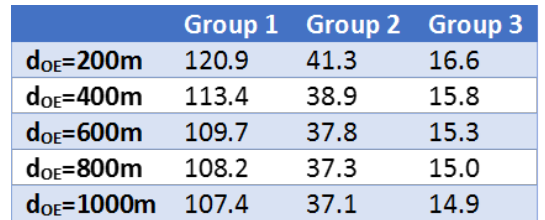
Table 2. Updated average density of radio access nodes including the added new Cabinets for each group of cities and for variable d OE